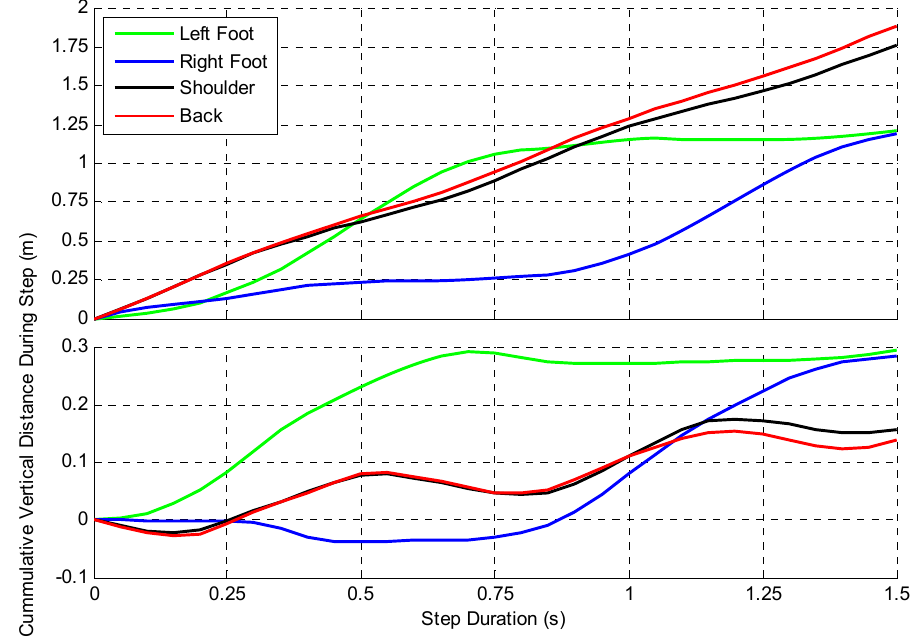
Figure 10. Hiker’s Average Displacement at Various Sensor Locations during each